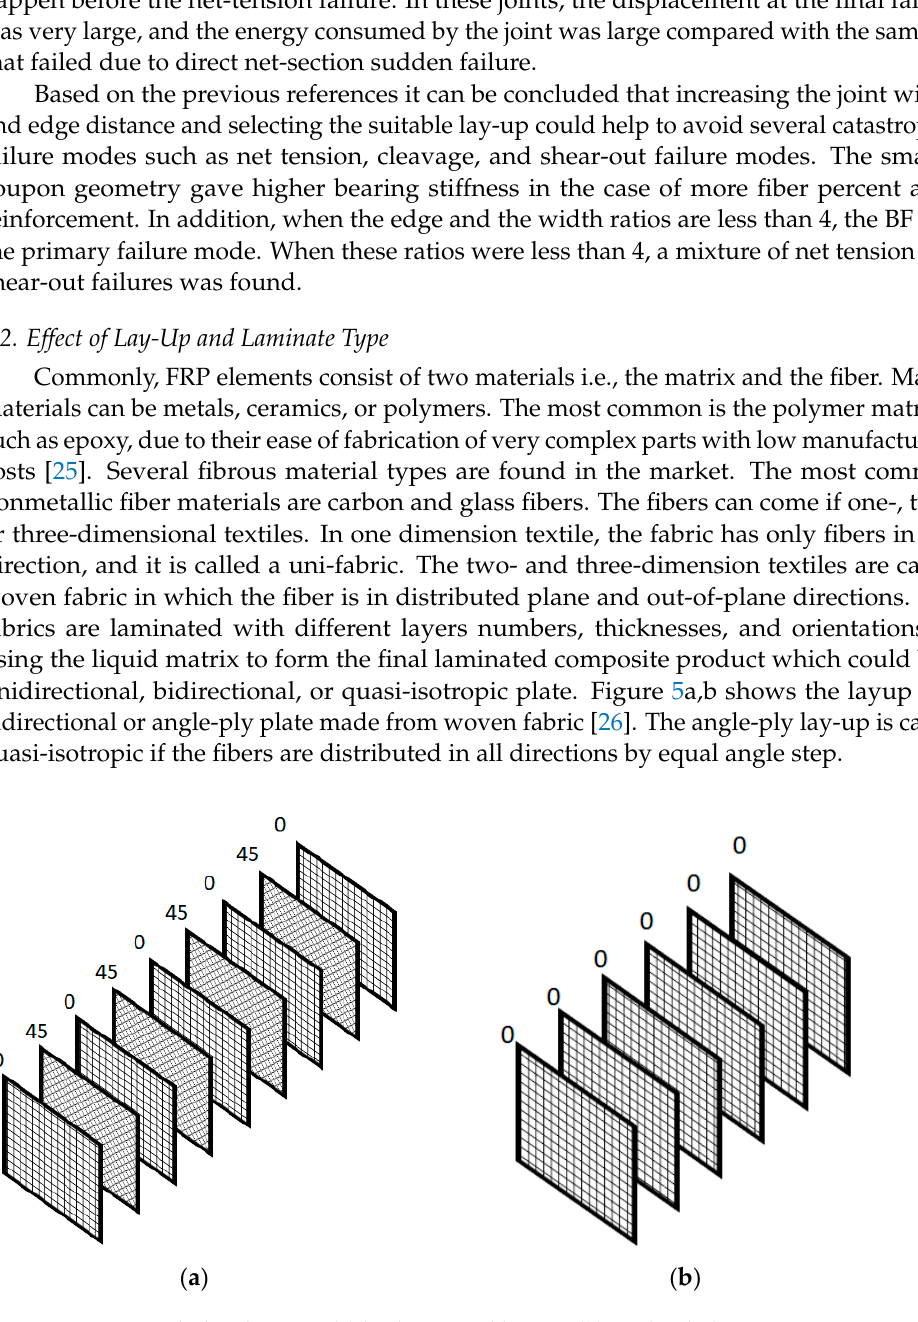
Figure 5. Laminated plate lay-ups: ( a ) bi-directional lay-up, ( b ) angle-ply lay-up.